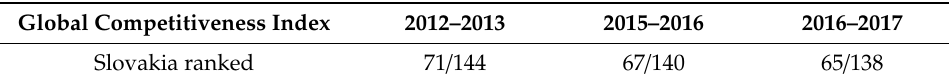
Table 9. Global Competitiveness Index